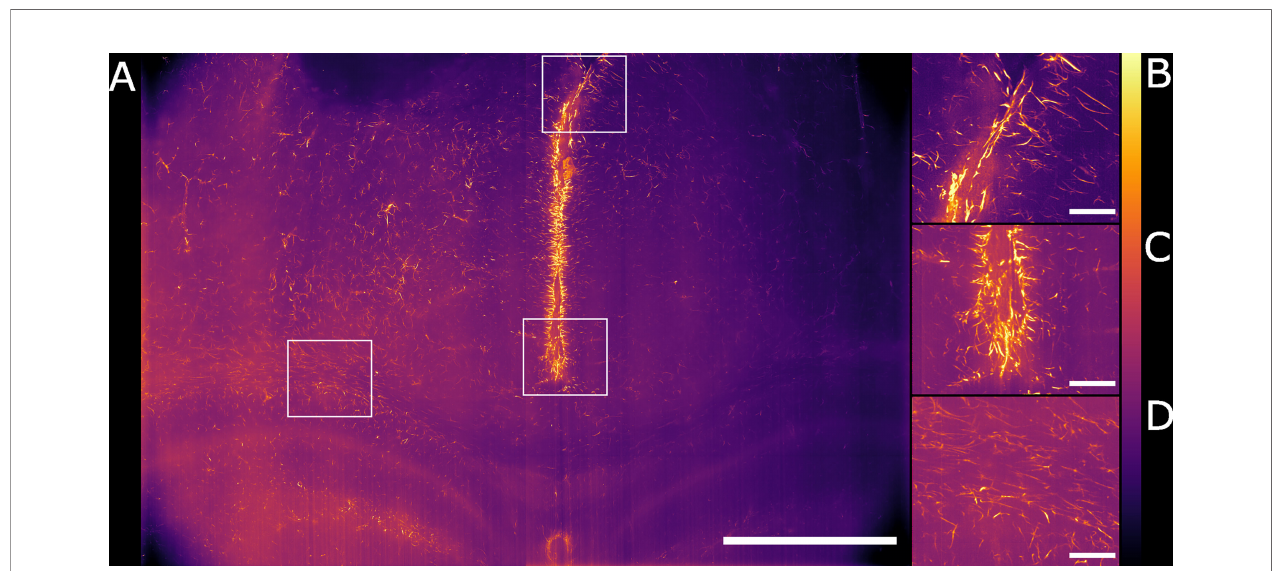
FIGURE 4 | Maximum intensity projection of the sub-volume shown in Figure 3B after deconvolution. The full FOV is shown in (A) . (B, C) highlight sub-regions in which both astrocytes and ependymal cells are resolved. (D) focuses on a sub-region in which the sole presence of GFAP reactive astrocytes is detected. The look- up table is mpl-inferno. The scale bar is respectively (A) 1000 µm and (B – D) 100 µm. The images were converted to 8-bit values (0-255). A comparison between deconvolved and non-deconvolved data is available in Supplementary Figure 1